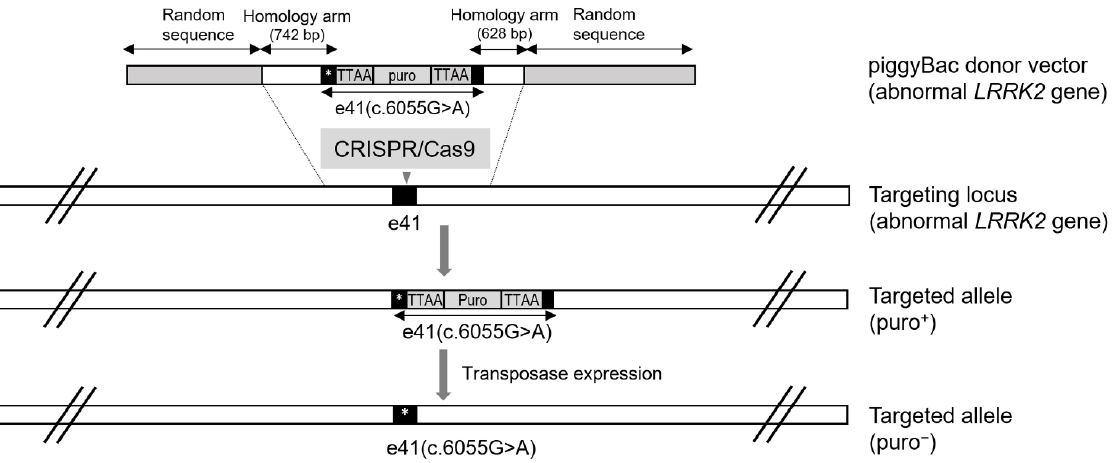
Figure 5. Generation of LRRK2 G2019S-mutant cell by CRISPR/Cas9 and piggyBac transposon system. In the piggyback donor vector, the TTAA sequence upstream of puro was a silent mutation from TAAA. The selection marker between the TTAA sequences is seamlessly released by transposase.